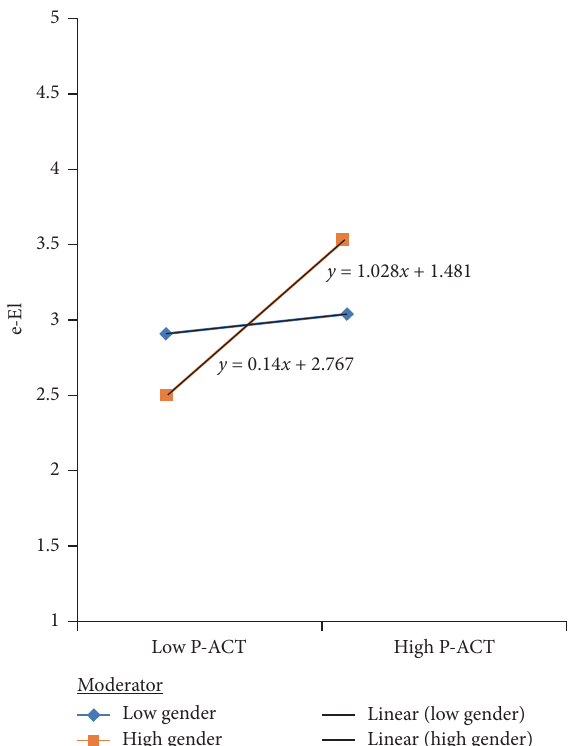
F IGURE 8: Graphical representation of interaction effect between P-ACT and e-EI. Gender strengthens the positive relationship between P-ACT and e-EI. Source: calculated by authors based on Lowry and Gaskin